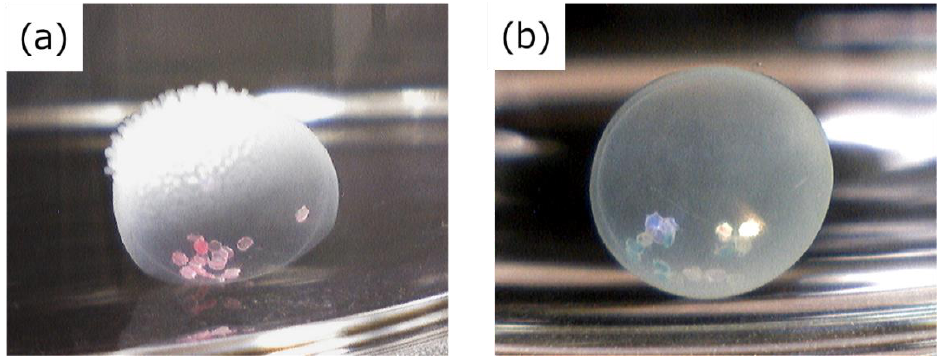
Figure 7. Photographs of HSBC gel encapsulating cosmetic glitter. ( a ) Encapsulation by non-uniform and ( b ) uniform BC gelatinous membranes.